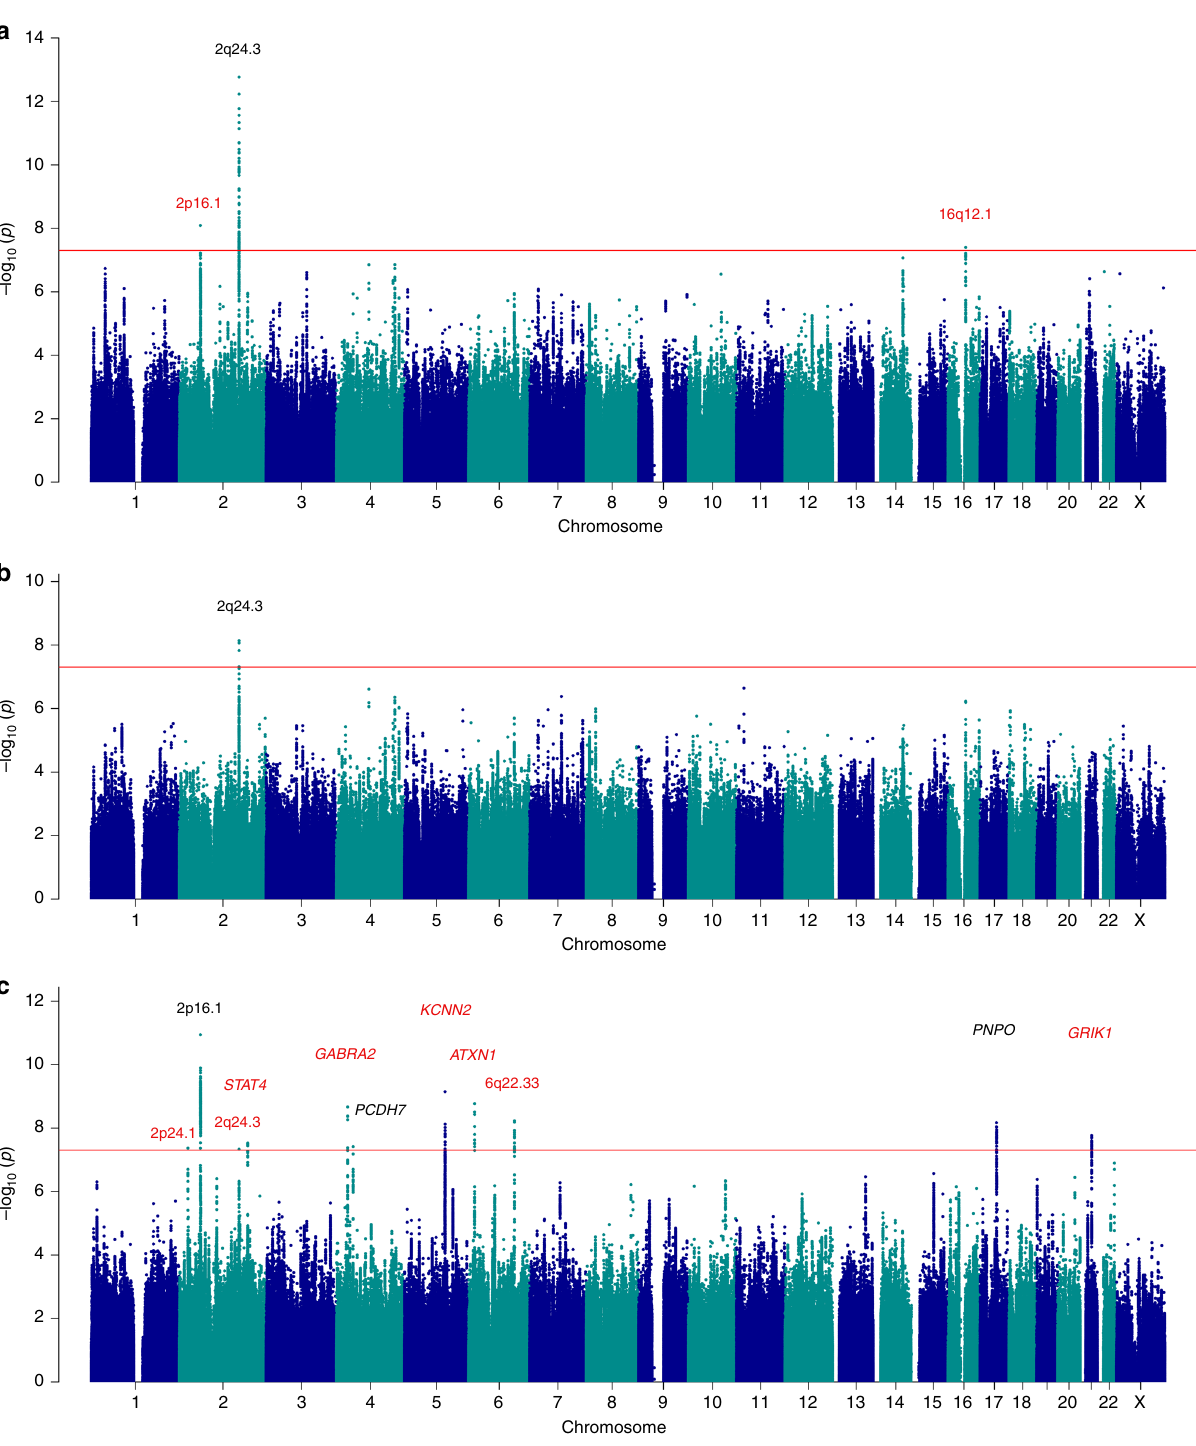
Fig. 1 Manhattan plots for epilepsy genome-wide association analyses. Genome-wide association analyses of a all epilepsy, b focal epilepsy, and c genetic generalized epilepsy. Negative log 10 -transformed P -values ( Y -axis) are plotted against chromosomal position ( x -axis). P -values were calculated with METAL using fi xed-effects trans-ethnic meta-analyses. The red line represents the genome-wide signi fi cance threshold ( p < 5 × 10 − 8 ). Previously known loci are indicated in black; novel loci in red. The names above each locus represent the prioritized gene in the locus (see Fig. 2) or the name of the locus itself in case of multiple prioritized genes in the